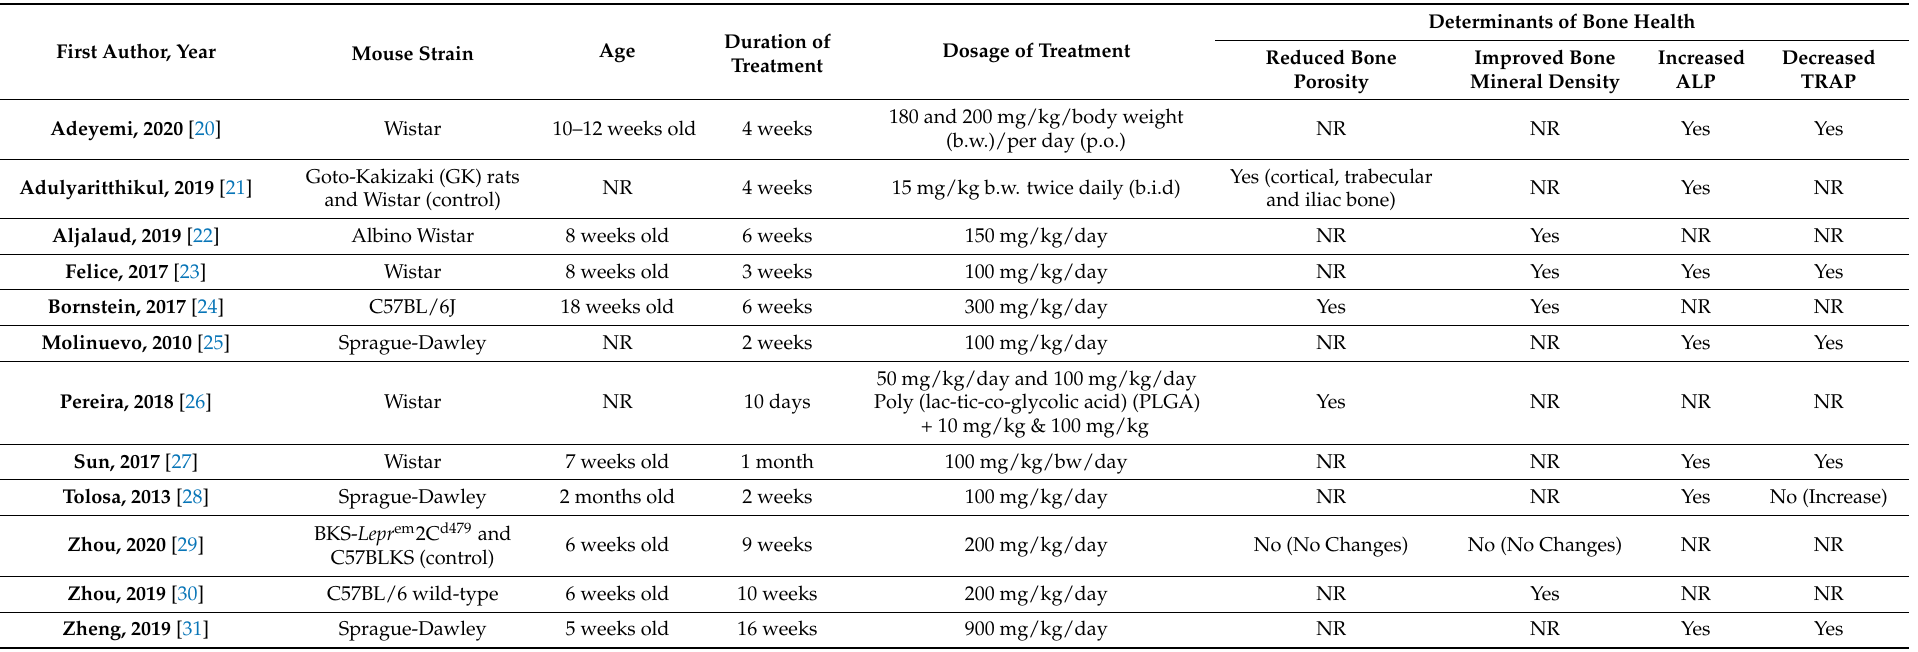
Table 2. Summary of studies that reported on the effects of metformin on bone mineral density in animal models with type 2 diabetes